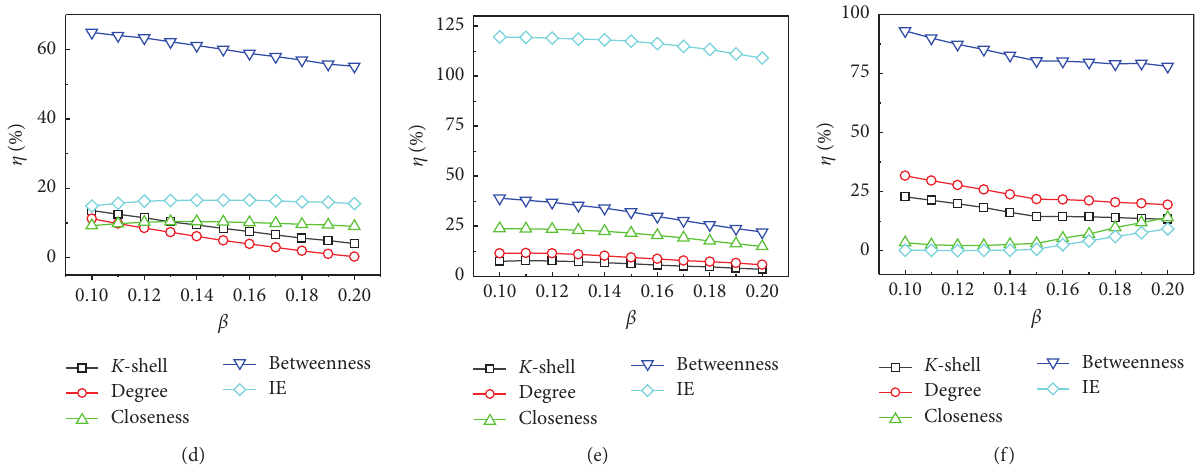
Figure 5: (Color online) The figure shows the improvement of ratio η for Kendall’s Tau as making a comparison between the IIE method and the benchmark methods in six networks. We set β ∈ [ 0 . 1 , 0 . 2 ] and μ � 1. (a) US air. (b) Polblogs. (c) E-mail. (d) Soc-hamsterster. (e) Facebook. (f) LastFM.